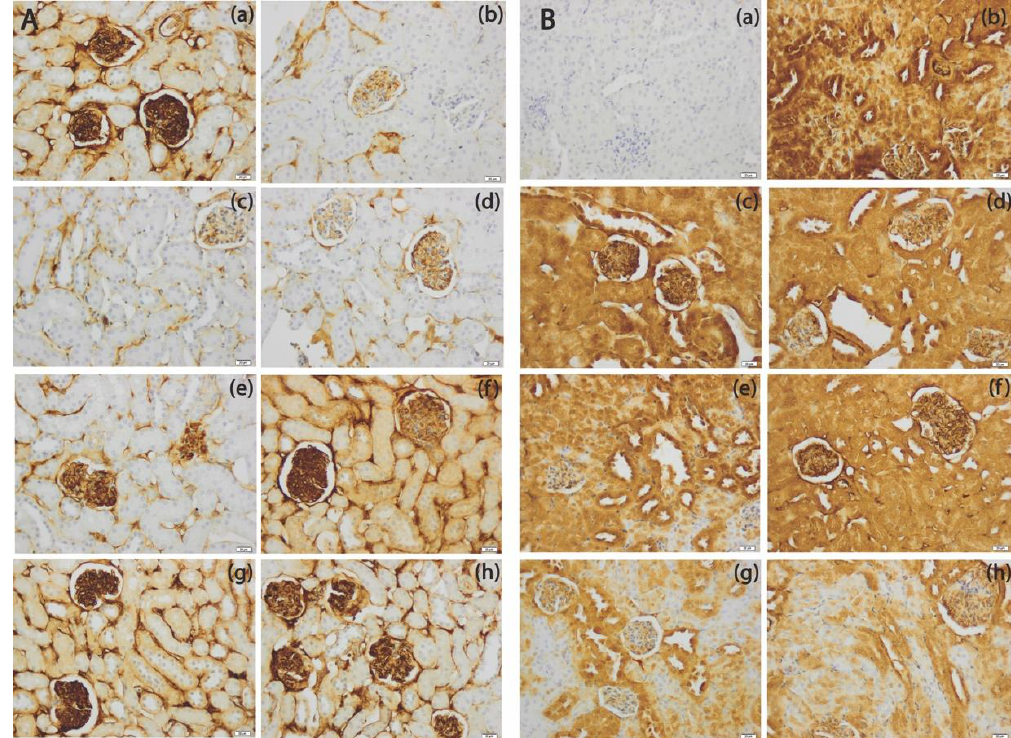
Figure 5. Renal immunohistochemical expression of Bcl-2 ( A ) and Bax ( B ) in: Groups: Control ( a )-mice received only water; Cadmium group ( b )-mice received orally 5 mg/kg CdCl 2 ; 0.1 SeNPs + Cd ( c ) (0.1 mg/kg SeNPs + 5 mg/kg CdCl 2 ); 0.2 SeNPs + Cd ( d ) (0.2 mg/kg SeNPs + 5 mg/kg CdCl 2 ); 0.4 SeNPs + Cd ( e ) (0.4 mg/kg SeNPs + 5 mg/kg CdCl 2 ); 0.1 LSeNPs + Cd ( f ) (0.1 mg/kg LSeNPs+ 5 mg/kg CdCl 2 ); 0.2 LSeNPs + Cd ( g ) (0.2 mg/kg LSeNPs + 5 mg/kg CdCl 2 ); 0.4 LSeNPs + Cd ( h ) (0.4 mg/kg LSeNPs + 5 mg/kg CdCl 2